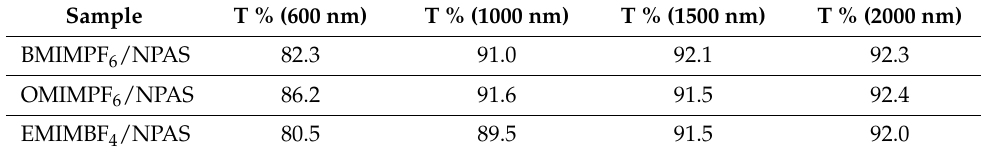
Wavelength (nm) Figure 6. Light reflection versus wavelength for: BMIMPF 6 /NPAS (red solid line), BMIMPF 6 /NPAS (green solid line), and EMIMBF 4 /NPAS (blue solid line) samples. Fluorescence spectra of the ILs covering the surface of NPAS are depicted in Figure 7, which shows an emission with excitation wavelength dependence (between 300 and 400 nm) mainly when EMIMBF 4 /NPAS and OMIMPF 6 /NPAS samples are considered.